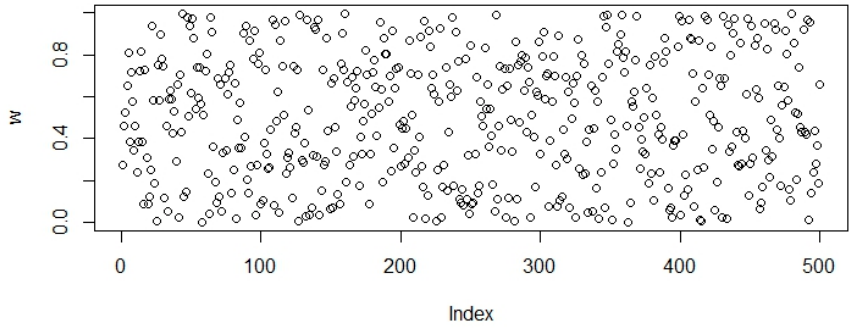
Figure 3. Population initialization using Halton distribution.